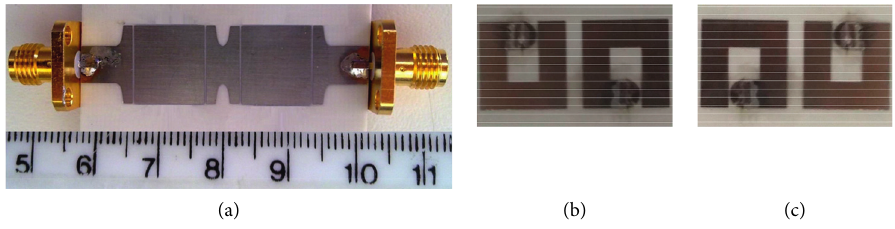
Figure 7: The layers of the fabricated filter: (a) top layer, (b) top view of the middle layer, and (c) bottom view of the middle layer (notice that the bottom layer (not shown in this figure) is the ground plane). Table 2: Comparison between the proposed filter and some other compact narrow BPFs reported in the literature (sorted by their size in the descending